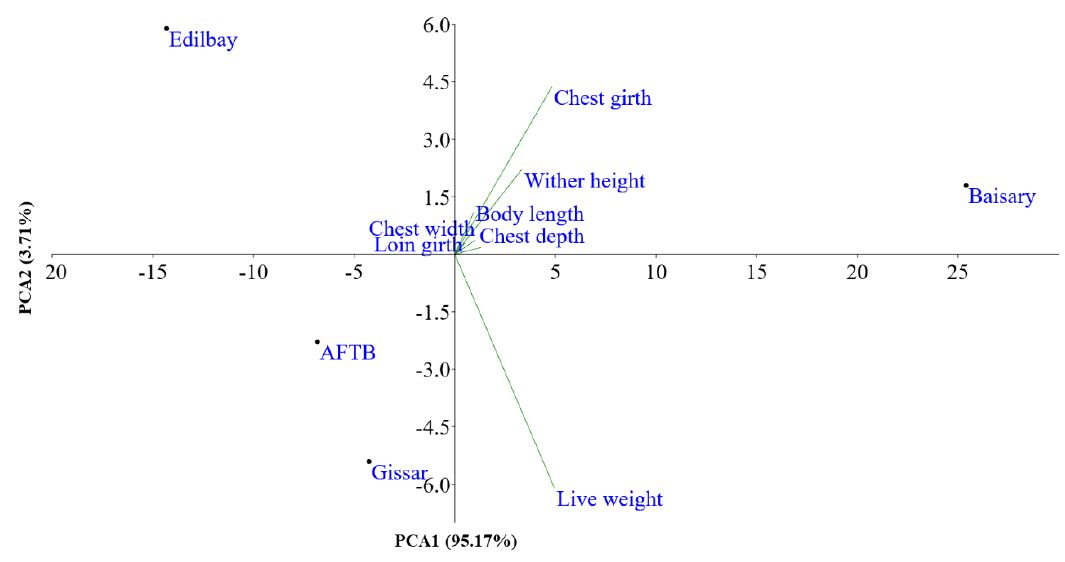
Figure 2. Principal components analysis of the physical traits of the sheep population.